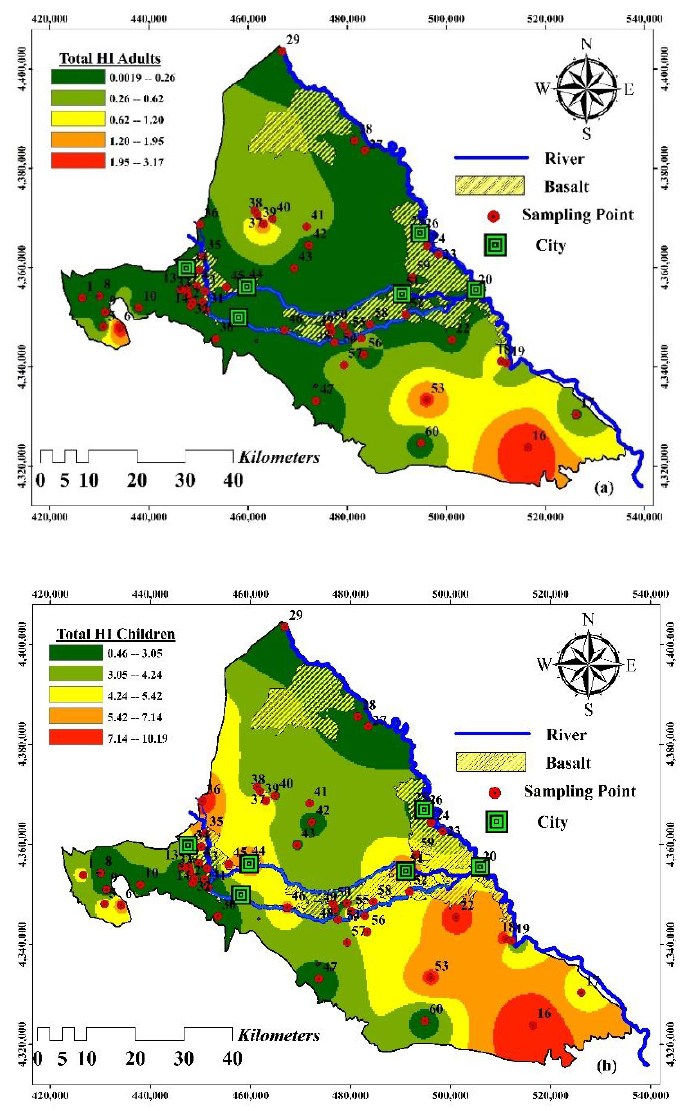
Figure 8. Spatial distribution of non-carcinogenic HHRA for ( a ) adults and ( b )